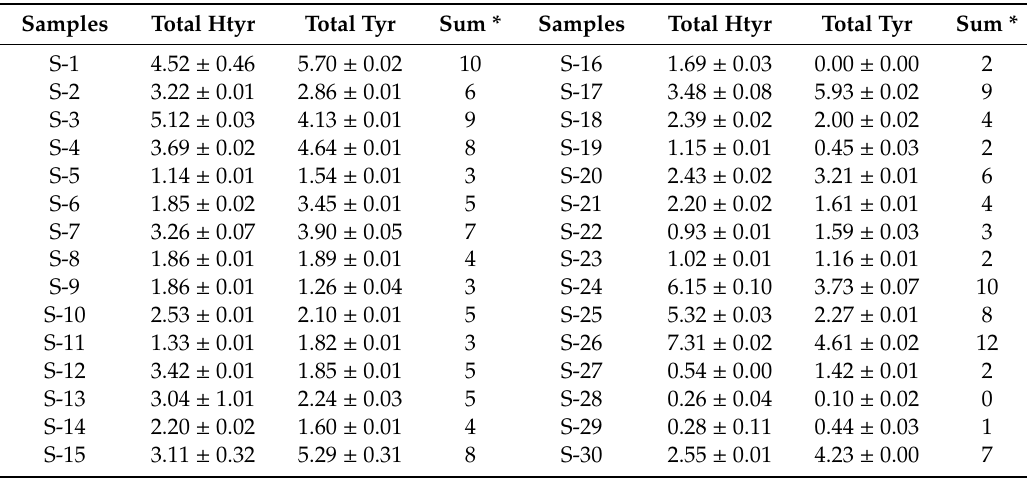
Table 1. Total (free and bound forms) Htyr and Tyr content (mg / 20 g oil) of virgin olive oil (VOO) samples according to protocol A.